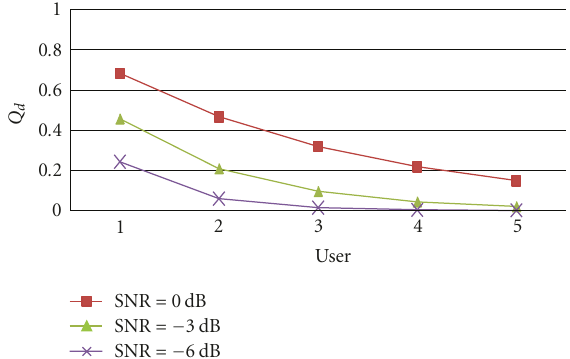
Figure 9: Performance of cooperative sensing using